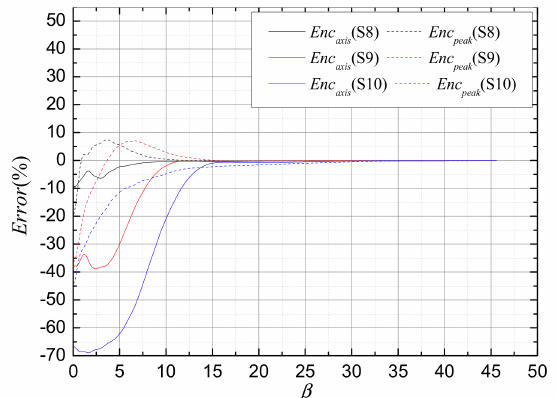
Figure 15. The relative error between the fast calculation results and 4D wave optics simulation results for Enc axis and Enc peak under S8, S9, and S10